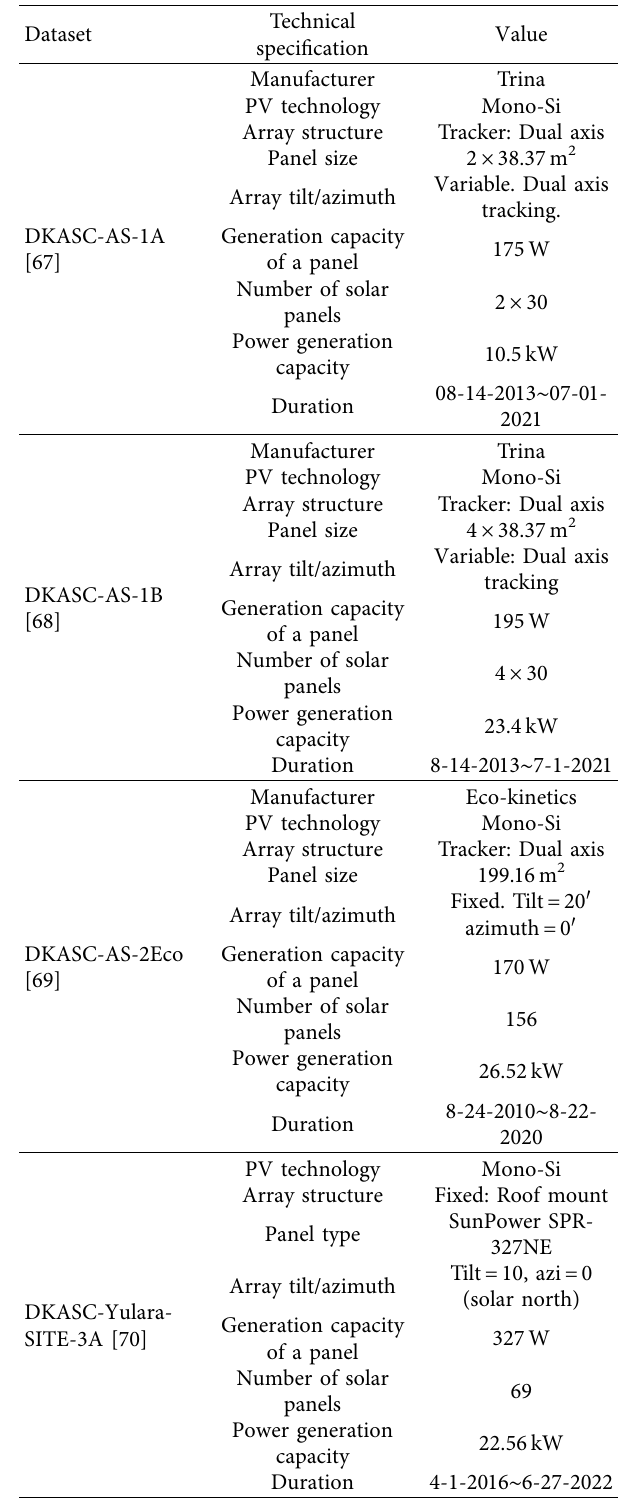
Table 3: Technical details of each dataset and their corresponding details about the power generation plants.